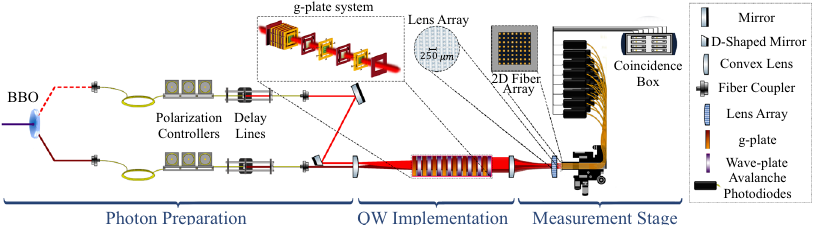
Fig. 3 Experimental apparatus for the 2D-QW implementation. Photon preparation. Two photons are generated by a spontaneous parametric down-conversion source and independently injected into single-mode fi bers. Polarization controllers are employed to change their polarization state, while delay lines enable controlling their degree of indistinguishability. For two-photon inputs, both photons are injected in the QW implementation and they propagate along two parallel paths. A lens system enlarges their waist radius and introduces a relative angle between the optical modes. The relative inclinations of the optical modes represent different lattice positions. In this way, the photons start the walk at positions ( − 1, 0) and (1, 0) of the lattice. In the single-particle case, one of the two photons is directly measured to act as a trigger. QW implementations. The quantum walk is performed by using waveplates and g-plates arranged in a cascade con fi guration. Each g-plate is controlled independently by tuning its phase retardation via a voltage controller. Measurement stage. A lens system at the output stage converts the different momentum values into a spatial grid. Then, for single-photon acquisition, an array of micro-lenses is used to ef fi ciently inject the output modes in a 2D square-lattice fi ber array. Finally, each output fi ber is plugged into an avalanche photodiode detector connected to a coincidence electronic system. For the coherent light data acquisition, we inserted a beamsplitter between the last lens and the micro-lense array, and we positioned the CCD on the re fl ected path to perform image acquisition.